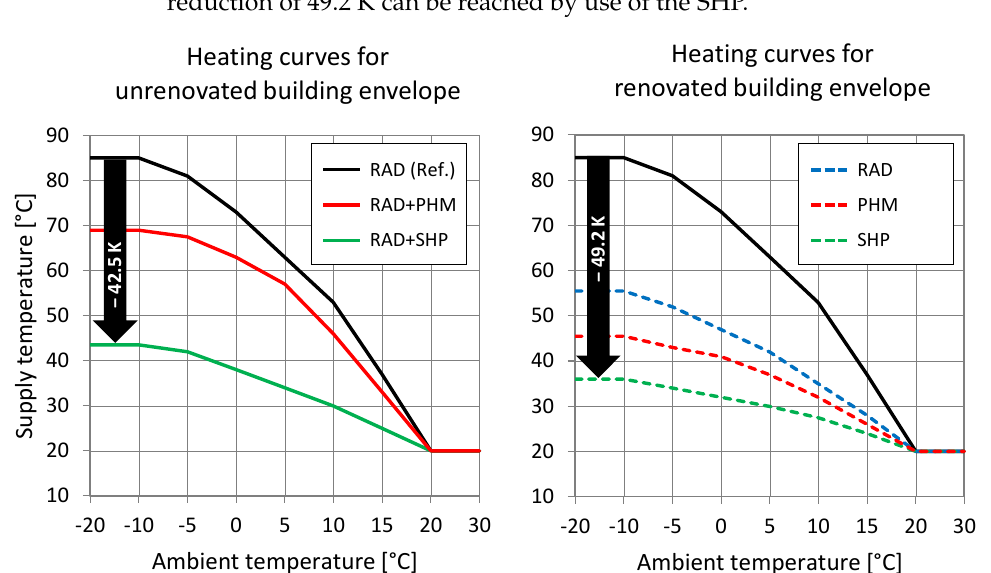
Figure 10. Heating curves for the architecture building with different renovation options.